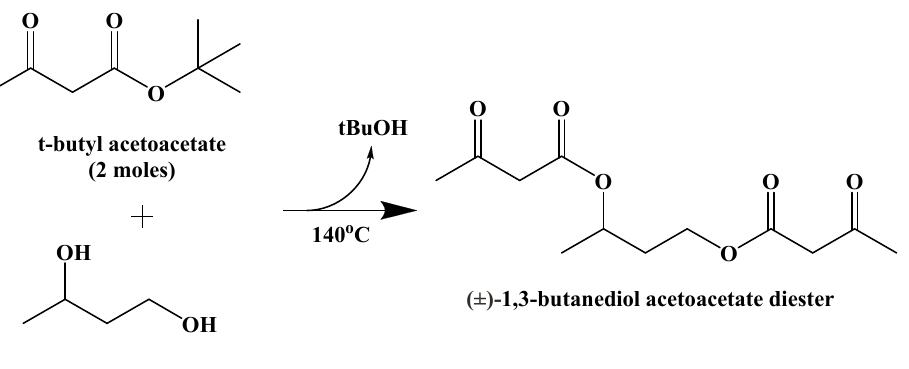
Figure 15. Synthesis of (±)-1,3-Butanediol Acetoacetate Diester.